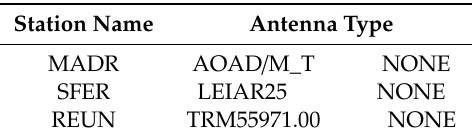
Figure 9. ZTD evaluation with respect to the IGS final product-bias (top) and standard deviation (bottom). Table 2. List of the stations that the receiver satellite antenna phase center o ff sets (PCOs) and variations (PCVs) are not calibrated with the strategy